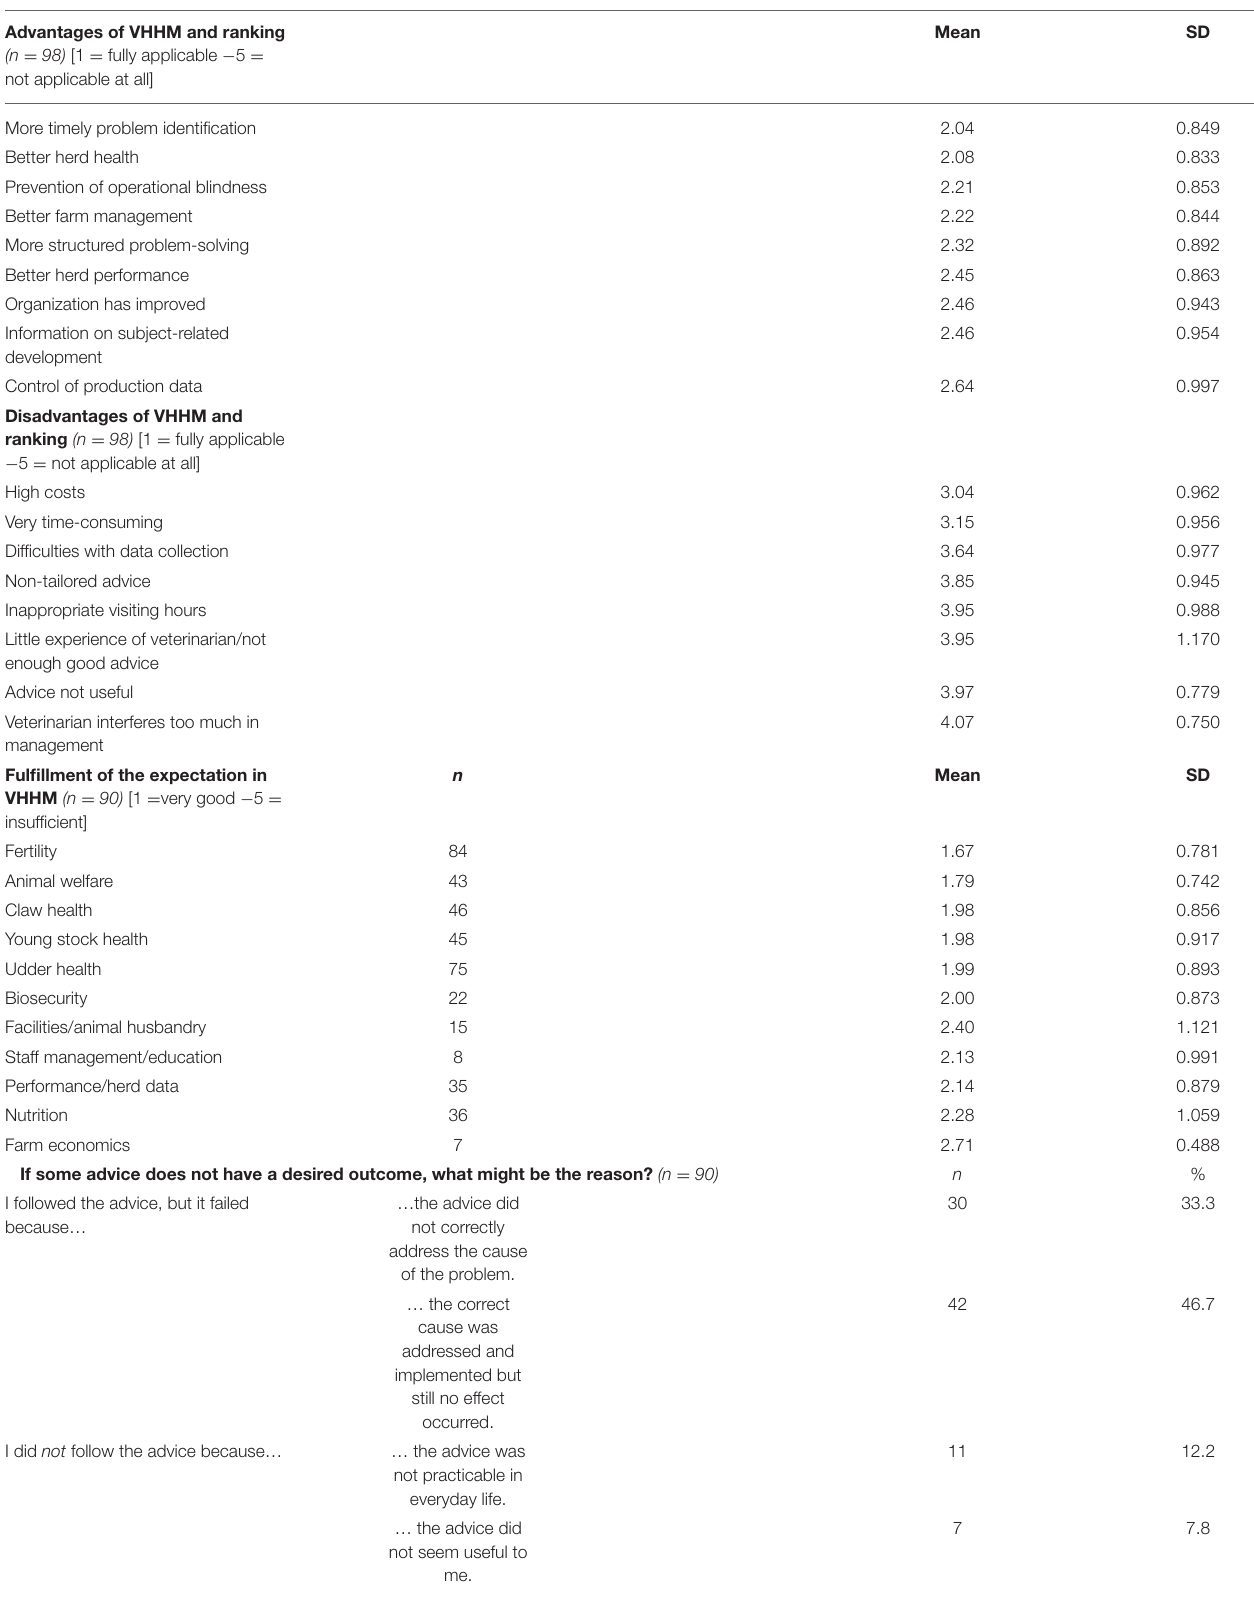
TABLE 6 | VHHM: Perceived advantages/disadvantages and fulfillment of